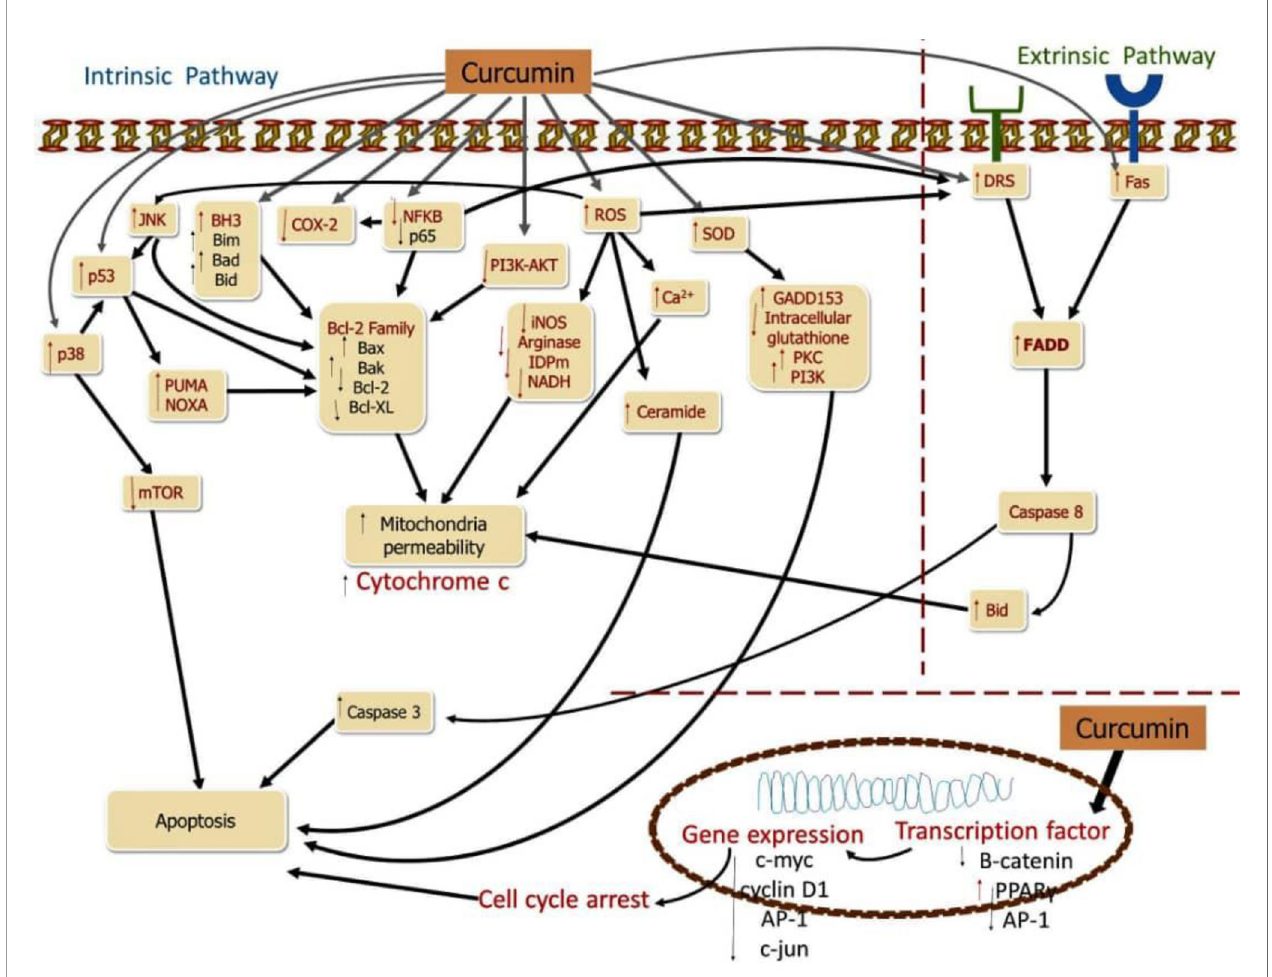
FIGURE 2 | Curcumin induces apoptosis in